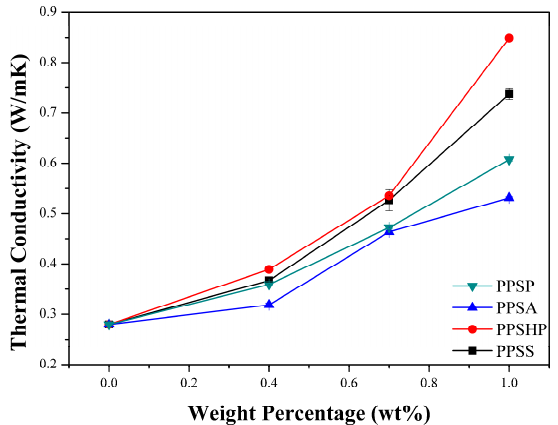
Figure 4. Thermal conductivity of the PPS/MWCNTs composites.